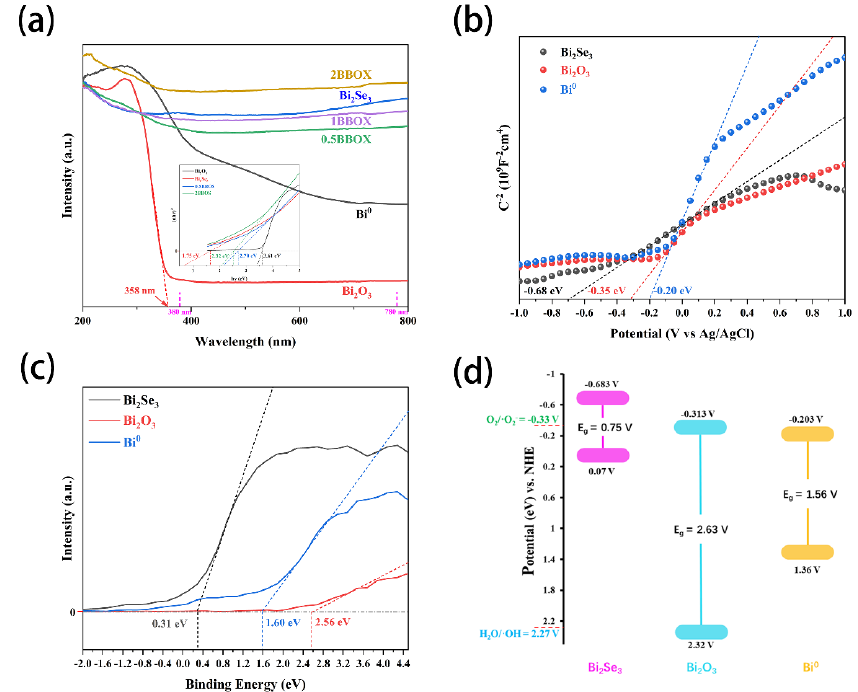
Figure 9. ( a ) UV-vis DRS spectra for the band gap of Bi 2 Se 3 , Bi 2 O 3 , and BBOS, ( b ) Mott-Schottky plots, ( c ) VB-XPS for valence band and ( d ) schematic band structure evolution of Bi 2 Se 3 , Bi 2 O 3 , Bi 0 , and 2BBOS.